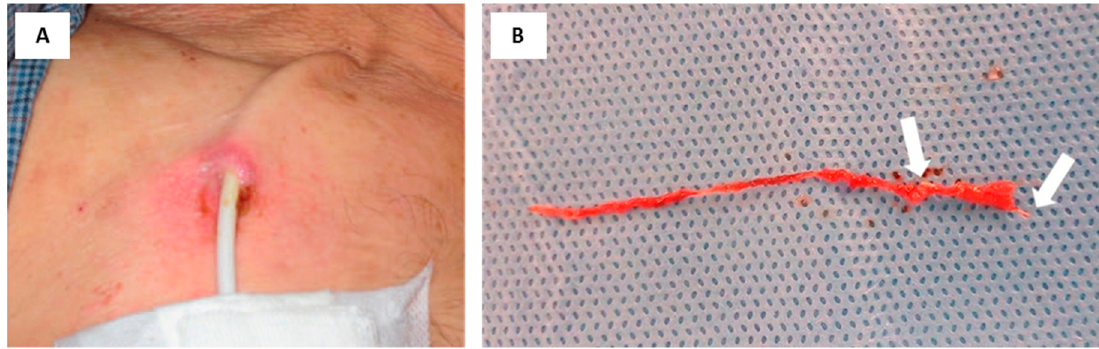
Figure 2. ( A ) Example of peritoneal dialysis catheter exit site infection. ( B ) Fibrin sheath formation was detected around the tip of the removed catheter (arrow). Reproduced with permission from: Lok